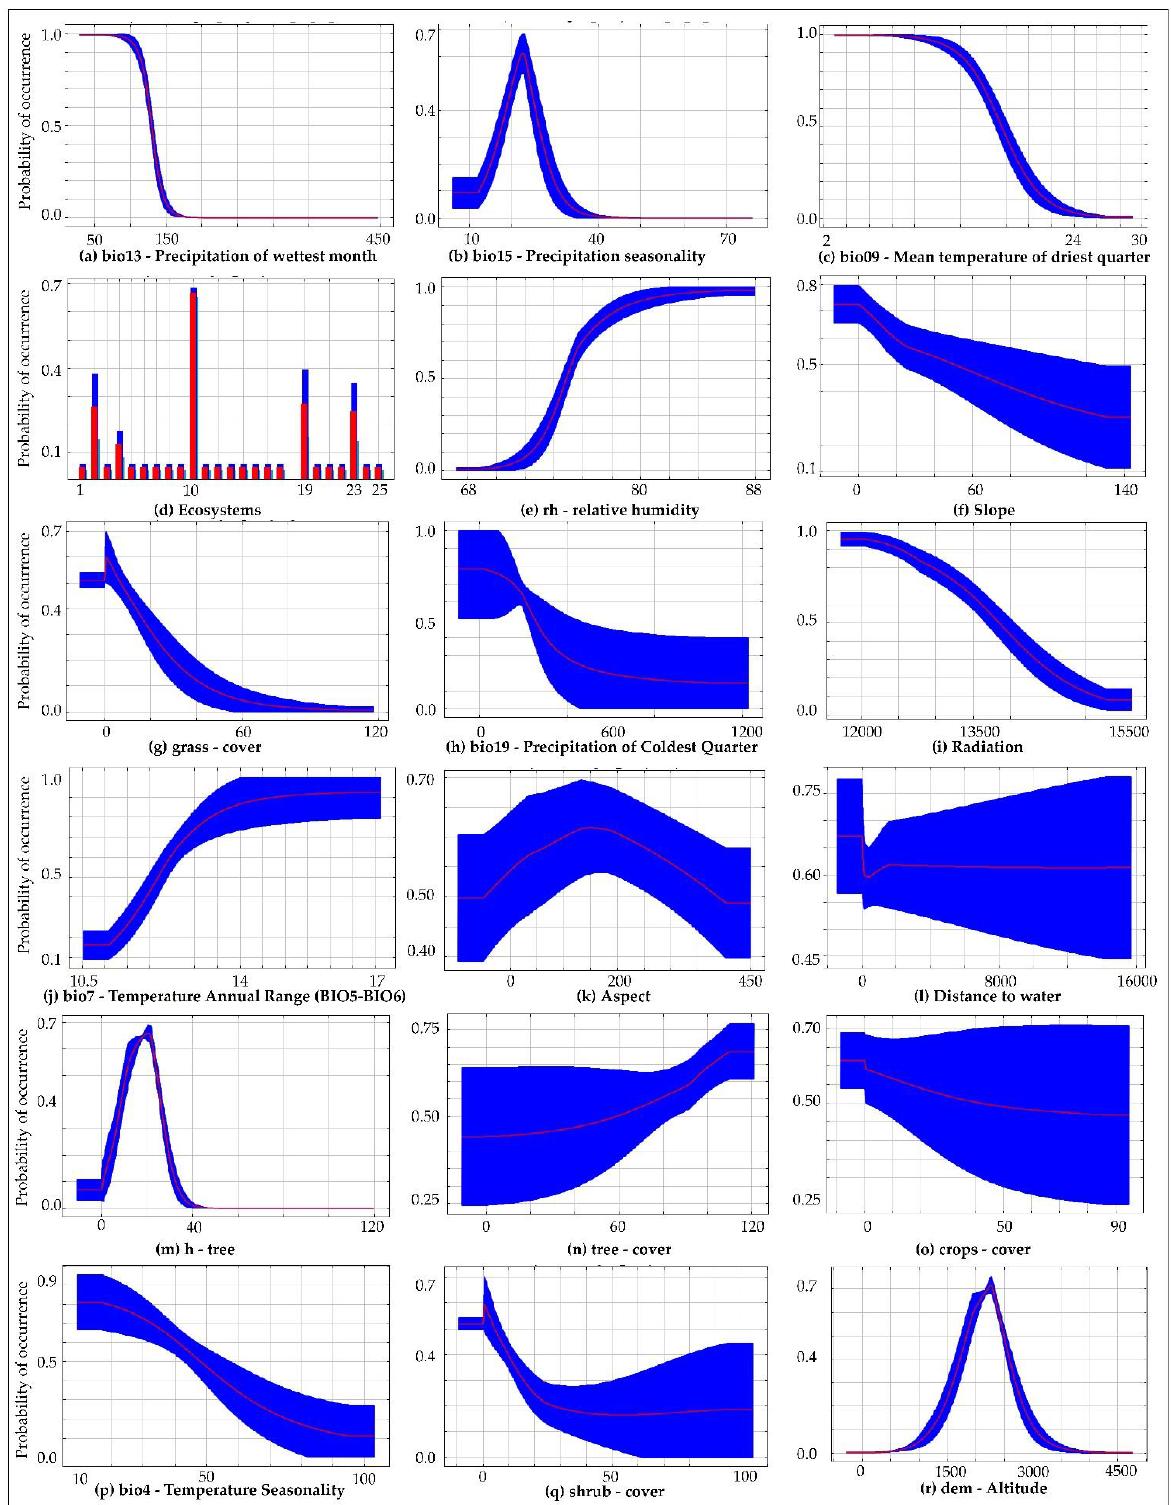
Figure 5. Response of environmental variables. In the figure, the y-axis indicates the probability of the species occurrence (logistic output). The red curves show the mean response, and the blue ranges are the standard deviation (± SD) calculated by 10 replicates. Most influential ecosystems for potential habitat suitability of X. loweryi (Figure 5d): 10, Yunga montane forest; 2, Yunga montane (pluvial) forest and 19, grassland/herbazales.